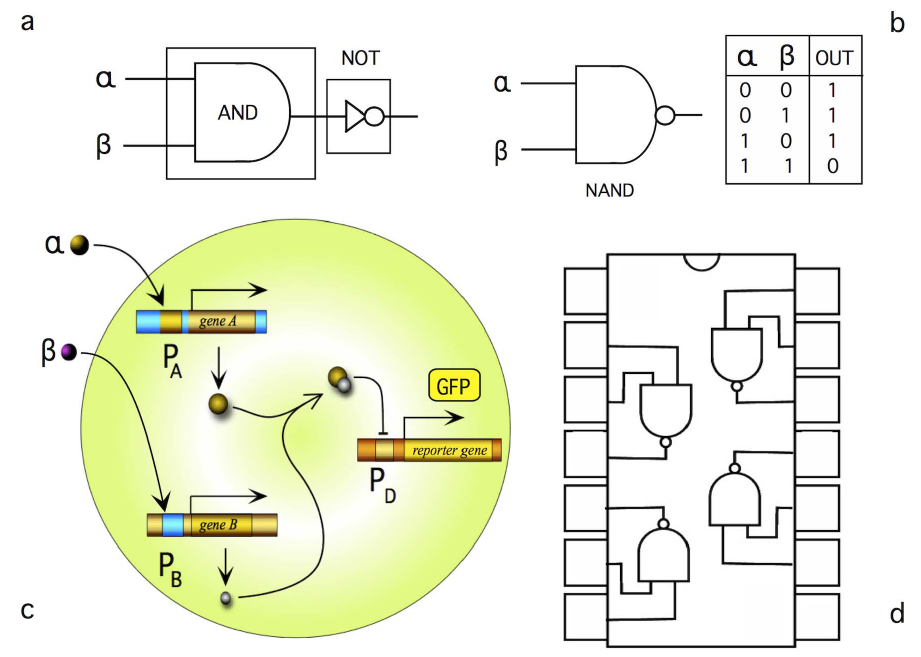
Figure 1. Simple logic gates can be implemented out from minimal sets of logic units. The NAND gate (a) is obtained as a sequential combination of AND and NOT gates. The compressed symbol is shown in (b) along with the truth table. An example of a synthetic implementation of the NAND logic can be made (c) using genetic regulatory elements A and B forming a regulatory heterodimer complex that prevents the expression of the reporter gene. In conventional electronics, combinations of such gates allow to construct more complex circuits and chips (d), which are then used as basic modules for further circuit designs.